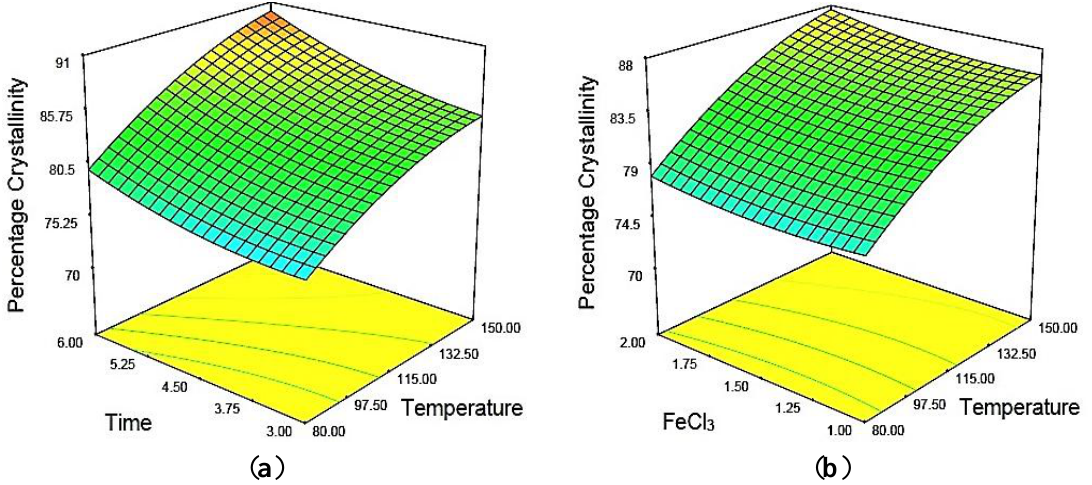
Figure 2. Response surface and contour plots of the combined effects of: ( a ) temperature and time; ( b ) temperature and catalyst concentration on the percentage of crystallinity ( y 1 ) of acid hydrolyzed MCC when the other two variables were at center